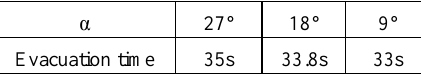
Table 2. Change trapezoidal export while keep length quantitative